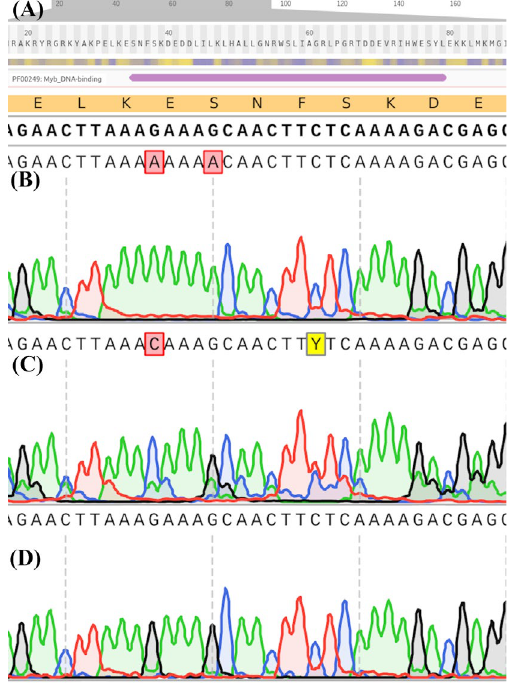
Figure 3. The localization of a DNA-binding domain in a MYBL2 gene ( A ) and the sequence of the beginning of this domain in B. oleracea varieties Gardener’s dream ( B ), Gulliver ( C ), and green B. juncea variety Vigorous ( D ).